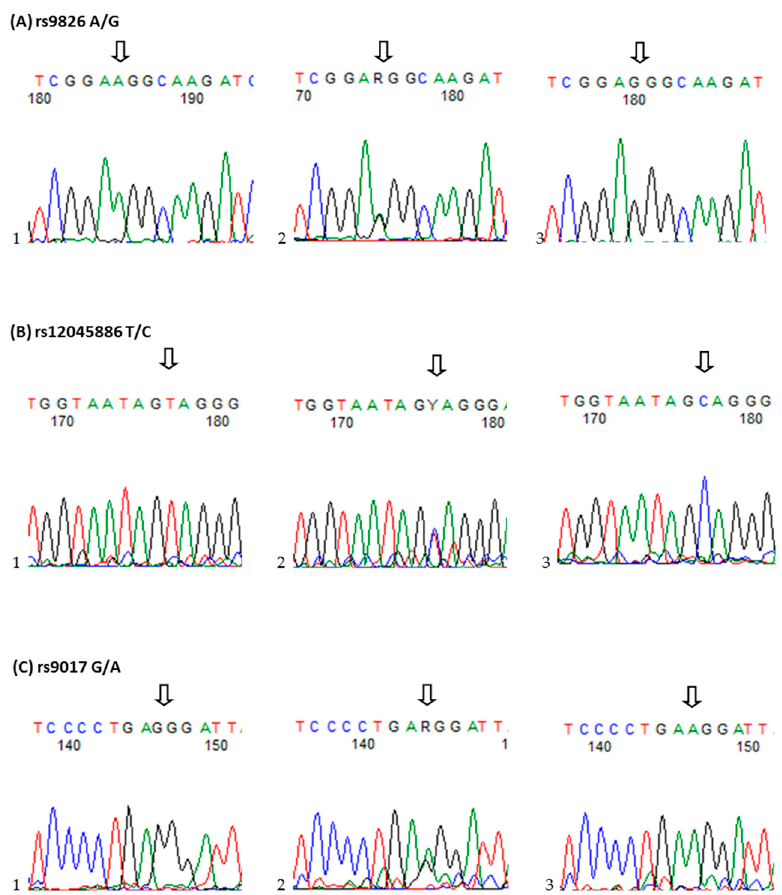
Figure 1. Sequencing map of genotype for RORc2 gene. ( A ) rs9826 A/G, the arrow of 1–3 showed AA, AG and GG genotypes, respectively.; ( B ) rs12045886 T/C, the arrow of 1–3 showed TT, TC and TT genotypes, respectively; ( C ) rs9017 G/A, the arrow of 1–3 showed GG, GA and AA genotypes, respectively.